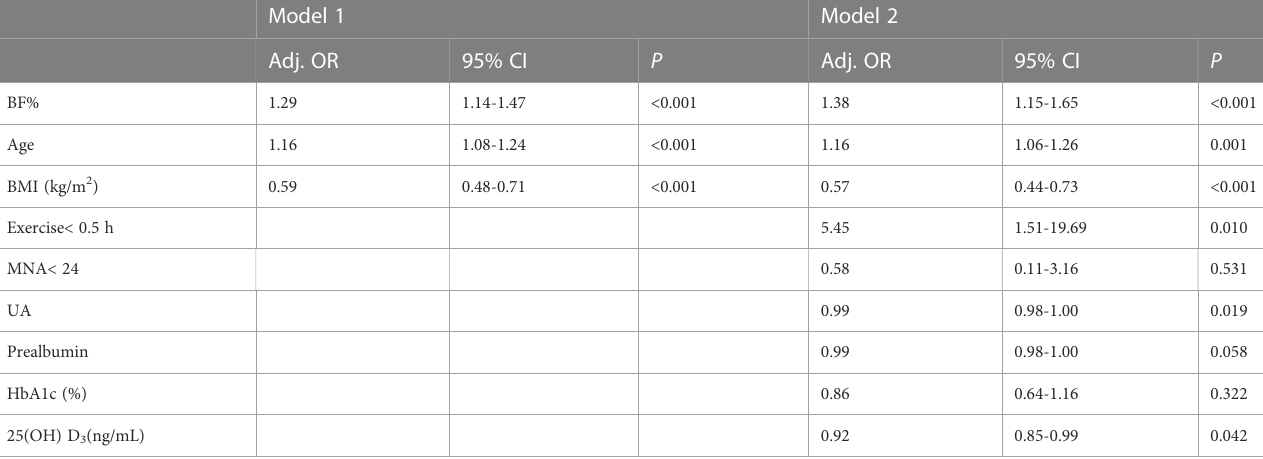
TABLE 4A Logistic regression models for risk factors associated with sarcopenia (male).